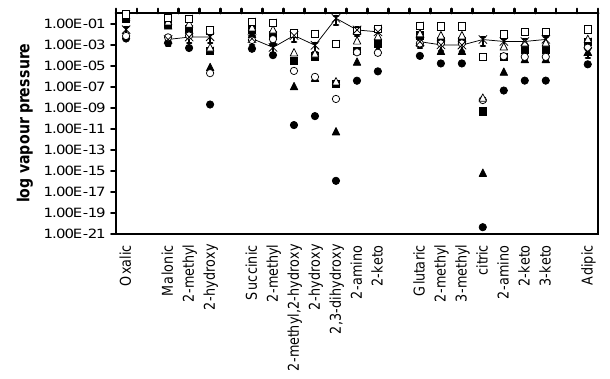
(cid:4) Myrdal and b ;